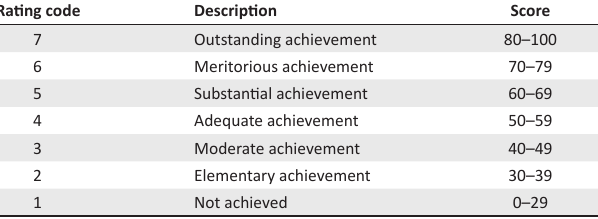
TABLE 1: The achievement scale for the National Senior